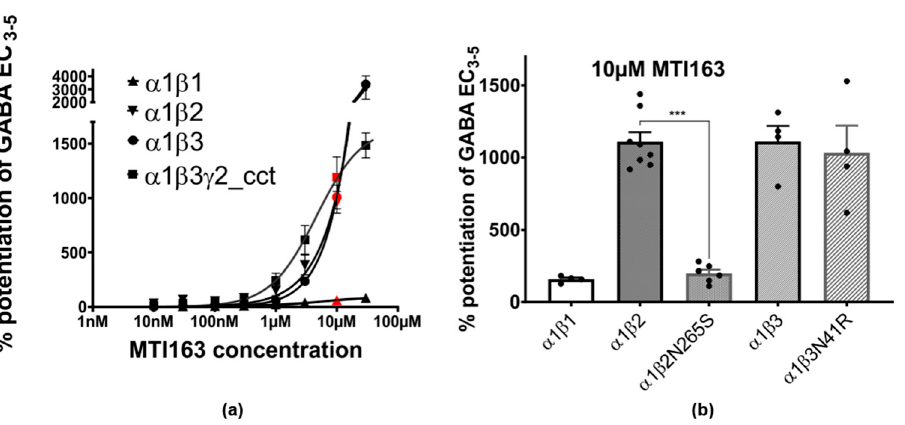
Figure 4. ( a ) Concentration-dependent MTI163 modulation of GABA EC 3-5 elicited current in α 1 β 1, α 1 β 2, α 1 β 3 and α 1 β 3 γ 2cct. Response at each point of measurement is represented as mean ± SEM ( n = 3–4). Response at 10 µ M is highlighted in red color. The y -axis is broken at indicated values for better visualization of all curves in the panel. For better visualization, a full scale version of the α 1 β 1 dose response curve is in the Appendix A (Figure A5). ( b ) Comparison of MTI163 modulation of GABA 3-5 elicited current in α 1 β 1, α 1 β 2, α 1 β 2N265S, α 1 β 3, and α 1 β 3N41R receptors at 10 µ M. Bars are given as mean ± SEM ( n = 4–8). Each individual data point is displayed by a dot. Statistically significant differences were determined by one-way ANOVA with Tukey’s multiple comparisons post-hoc test, *** corresponds to p < 0.0001.